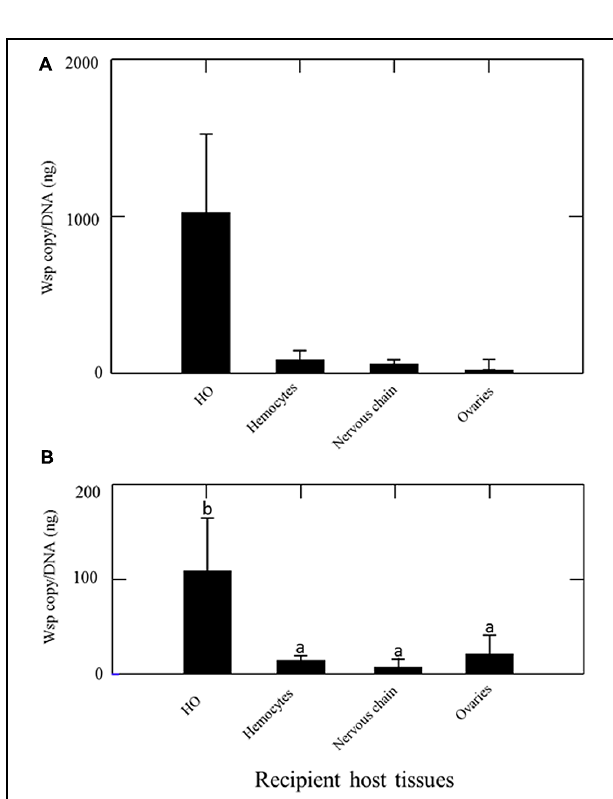
FIGURE 2 | Quantification of Wolbachia [ wsp copy/DNA (ng)] in asymbiotic recipient animals 15 days after their transinfection (A) by injection of hemolymph from symbiotic animals (B) by transplantation of HOs from symbiotic animals. Different letters indicate significant